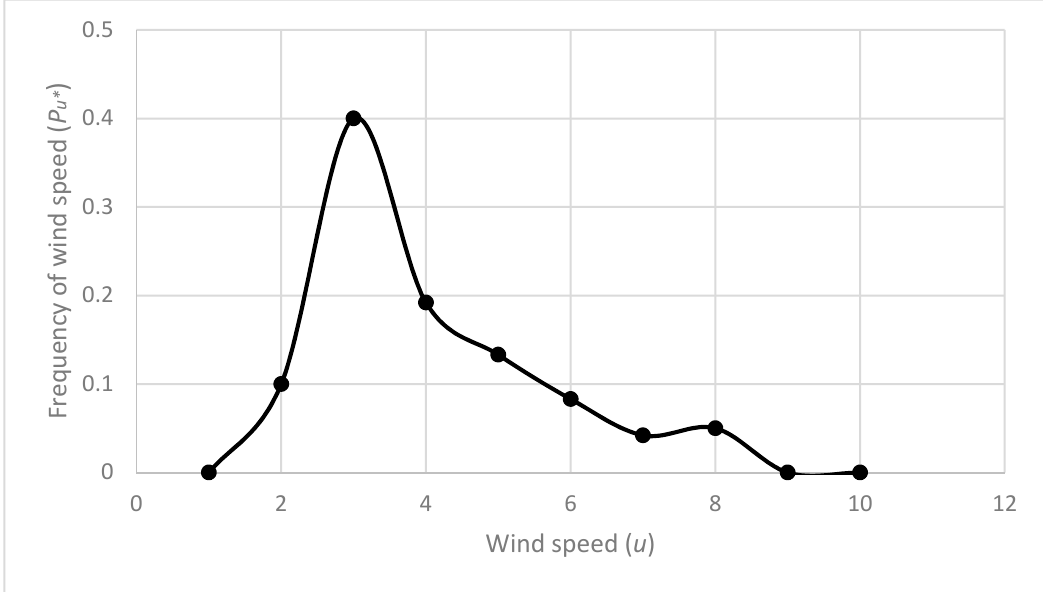
Figure 4. The probability distribution of the wind speed (u) measured at the headquarters of JER [38]. For each treatment, 500 evenly distributed transect lines were created to measure plant height, bare soil gap size, and vegetation cover in the upwind area of each treatment by using the same method in Section 3.3.1 on the classification map and vegetation layer. The measurement of plant height and bare soil gap size constructed P d and the measurement of vegetation cover is C in the previous equations. The code of the WEMO model was written in Python